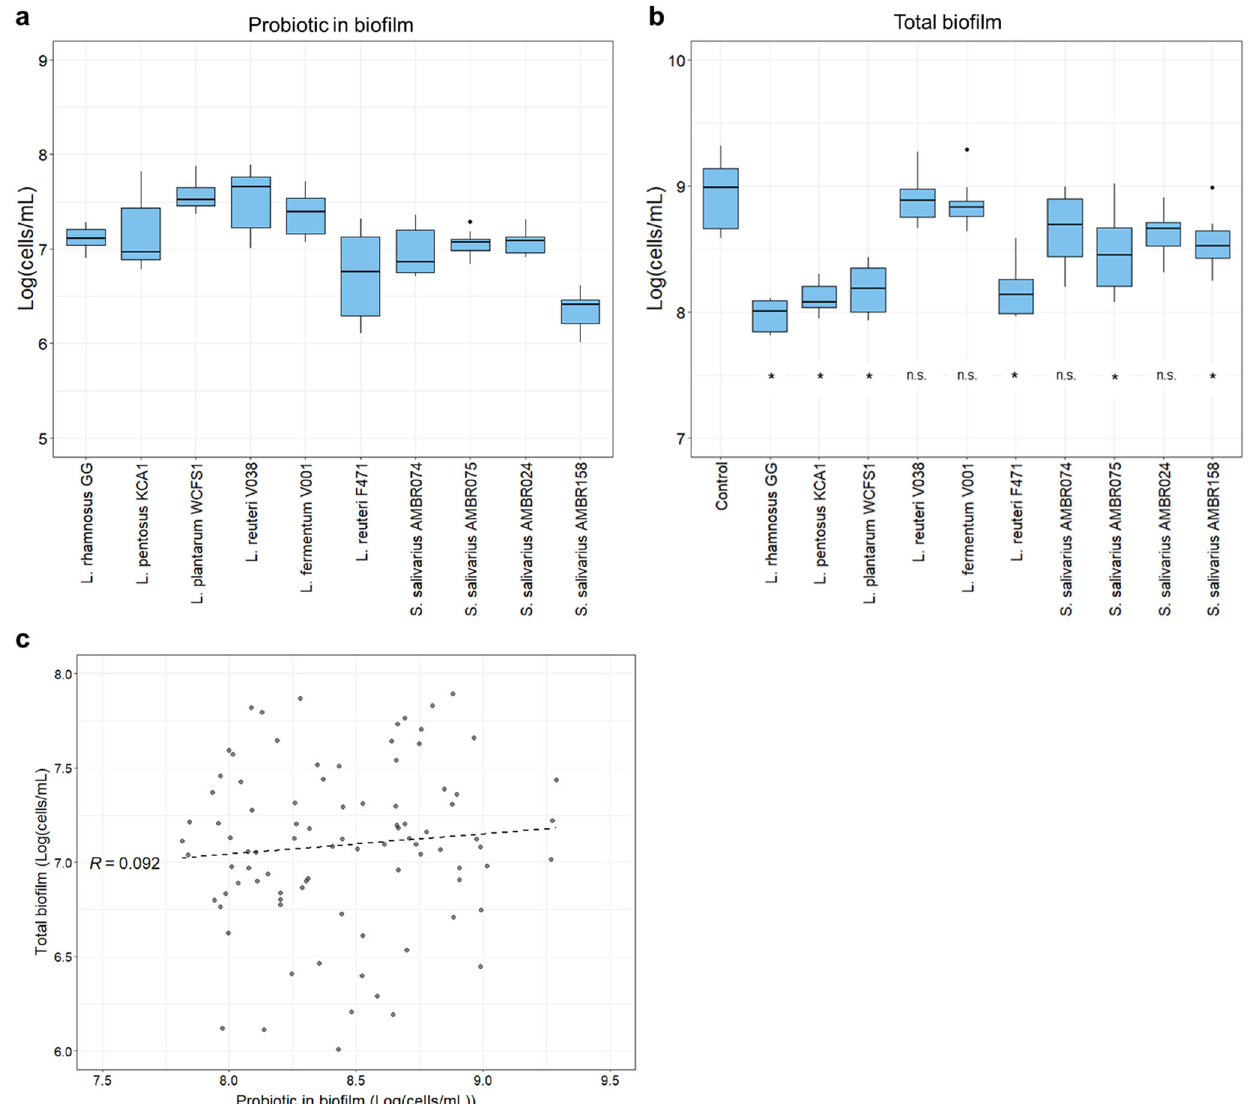
Fig. 2 Probiotic prevalence does not affect total bio fi lm counts. Probiotic prevalence in bio fi lms ( a ), total cells in the bio fi lms ( b ) and both plotted against each other ( c ). Probiotic abundance and total bio fi lm are presented as a boxplot of the log 10 cells per milliliter (log(cells/mL)) recovered from the discs of each probiotic per experiment (Tukey style boxplot with median centre line, IQR at 1.5, upper and lower hinges at 25th and 75th percentiles and whiskers at 1.5 IQR from the hinges). No correlation between the prevalence of the probiotic and the total bio fi lm was observed. Statistical differences in probiotic prevalence between conditions can be found in Supplementary Table 2. For the total bio fi lms, statistical differences from the control are depicted by an asterisk and otherwise as n.s. ( n = 9; nonparametric Kruskal-Wallis with Dunn ’ s